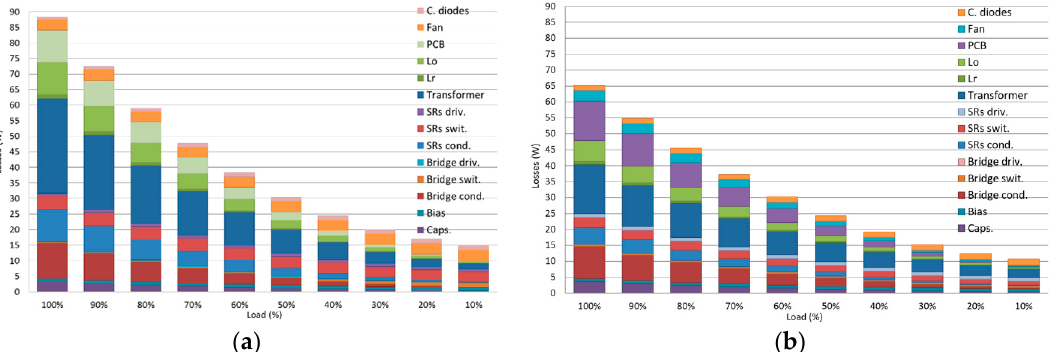
Figure 22. Overall estimation of losses based on the loss model and the experimental results. ( a ) Reference design. ( b ) Optimized design. Table 11. Summary of the distribution of losses in the reference design.